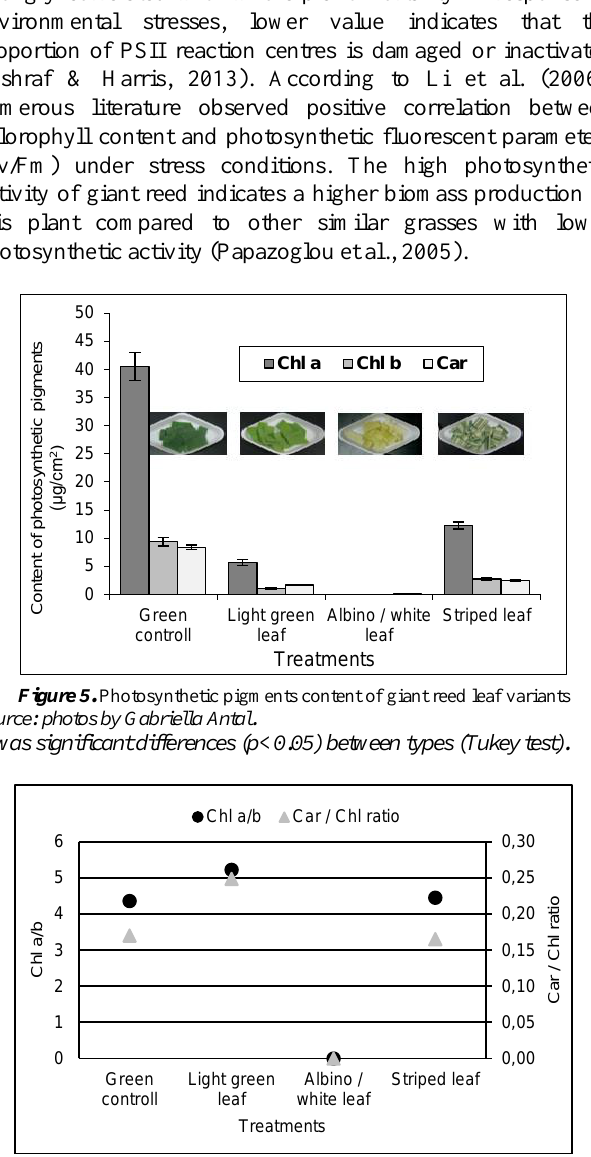
Figure 6. Chlorophyll a/b (left axis) and Carotenoids/chlorophyll ratios (right axis) in leaf variants of giant reed It was significant differences (p<0.05) between types (Tukey test).